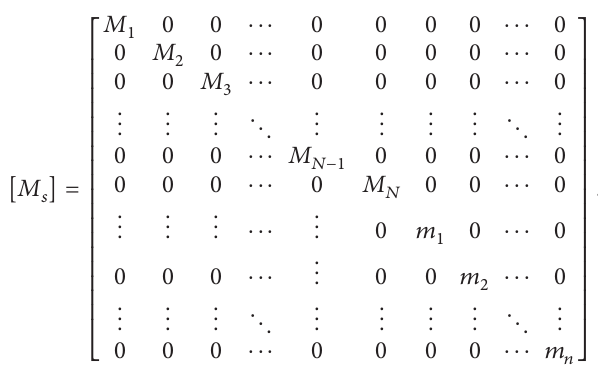
d-MTMDs is kept the same for comparison purpose in all the cases investigated. In the three cases, STMD, MTMDs,